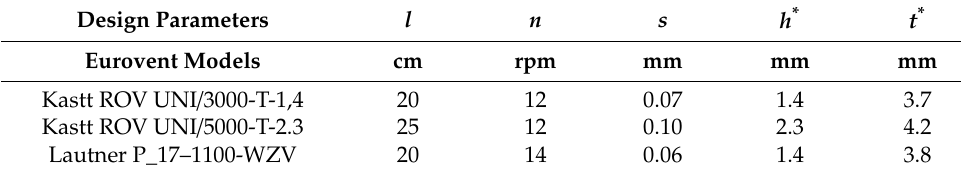
Table 4. Eurovent models.